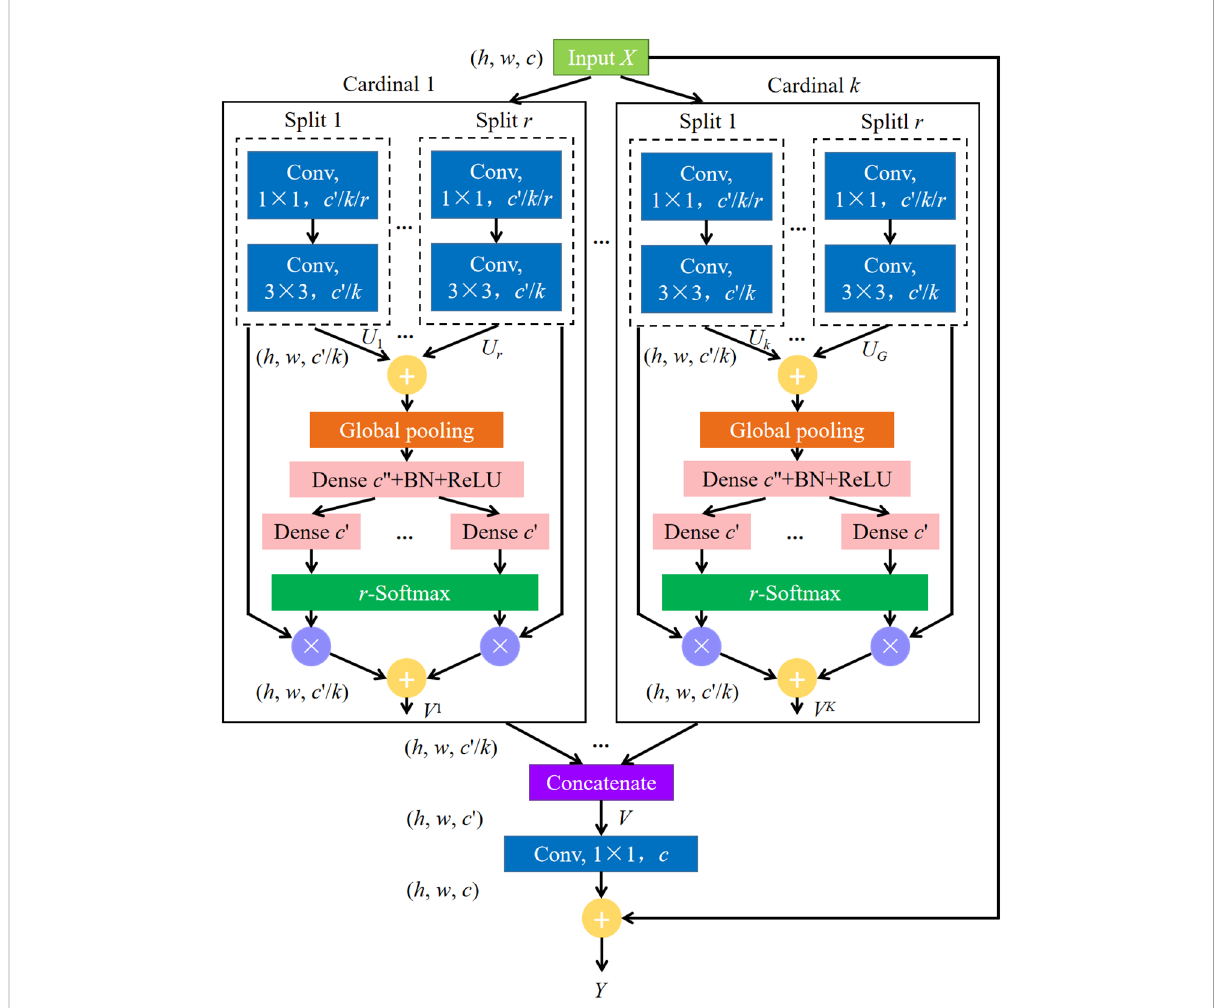
FIGURE 2 ResNeSt block. r is the number of Splits. r = 1, 2, … , R . k denotes the number of Cardinal, k = 1, 2, … , K . h , w and c represent the height, width and channel of the input feature map, respectively. Conv represents convolutional layer, and Global pooling means global average pooling. BN and ReLU are batch normalization and activation function,